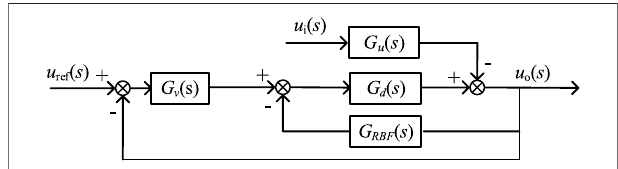
FIGURE 5 | Control model diagram with the proposed RBFNN strategy.